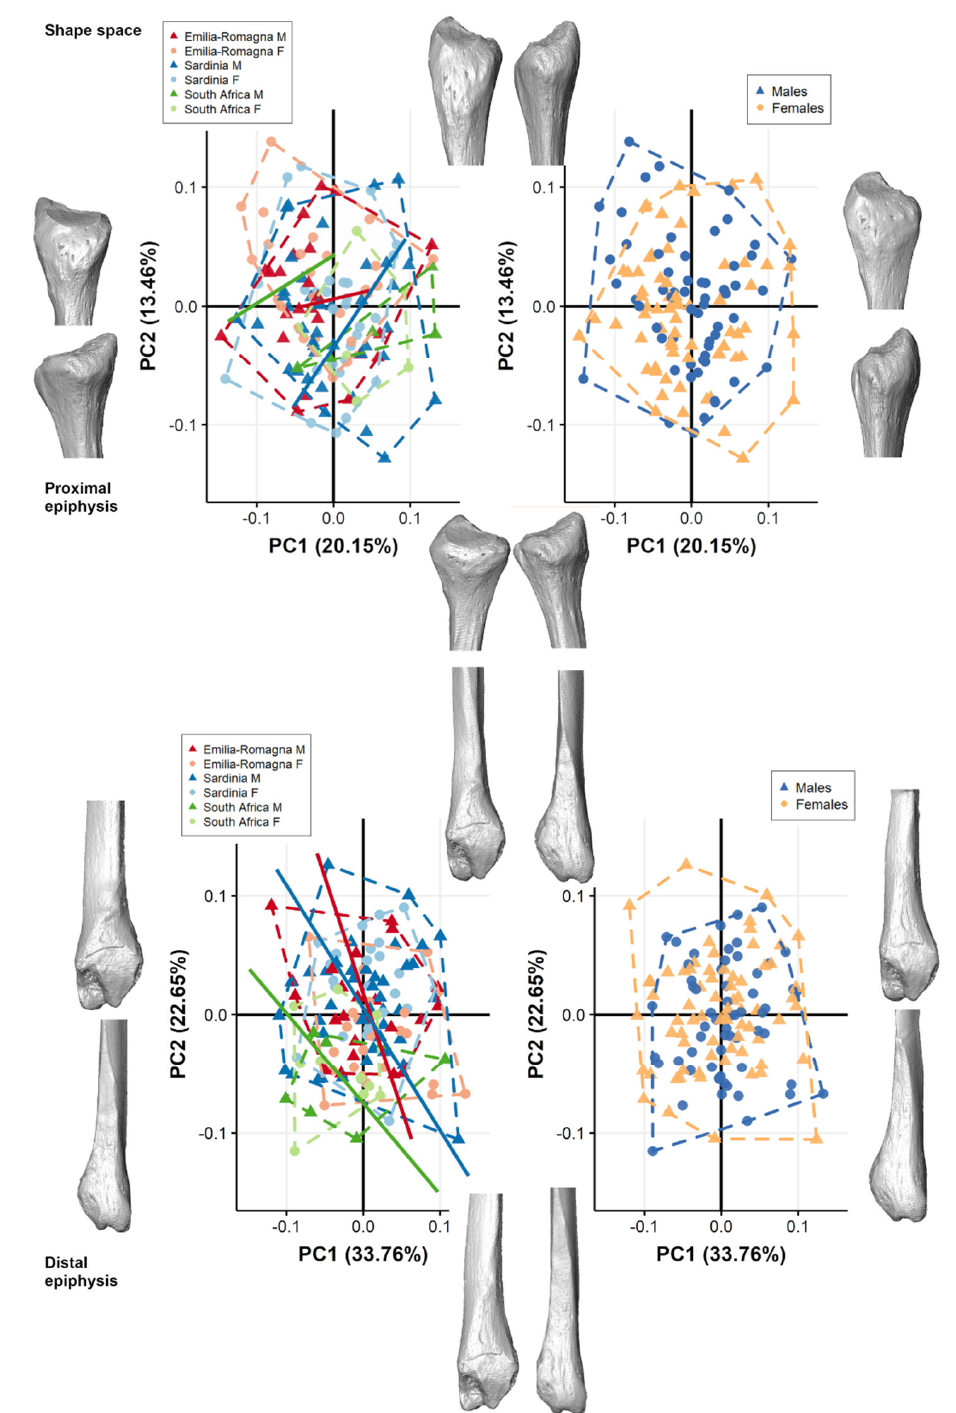
Figure 2. Scatterplot of shape-space PC scores for both proximal and distal epiphyses computed considering all populations pooled together, grouped by population (on the left ) and by sex (on the right ). For both proximal ( above ) and distal ( below ) extremities, positive and negative extreme shape variations along PC1 ( right and left ) and PC2 ( top and bottom ) are represented. Lines represent allometric trajectories for all populations. Allometric trajectories for ER (red line), SAR (blue line), and SA (green line) are represented.